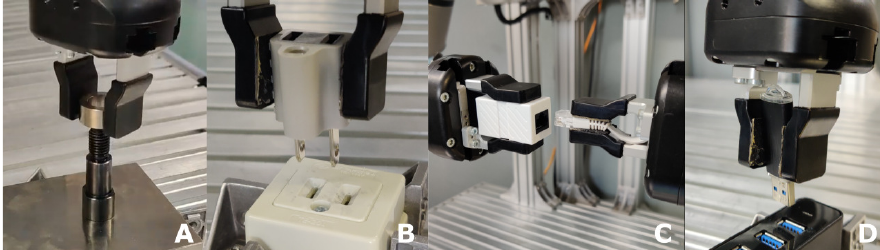
Figure 9. Several insertion tasks with different degrees of complexity. ( A ) Metal ring (high stiffness) with 0.2 mm of clearance. ( B ) Electric outlet requiring high insertion force. ( C ) Local-area-network (LAN) port, delicate with complex shape. ( D ) Universal serial bus (USB). Table 5. Success rate of learned policy in several insertion tasks.